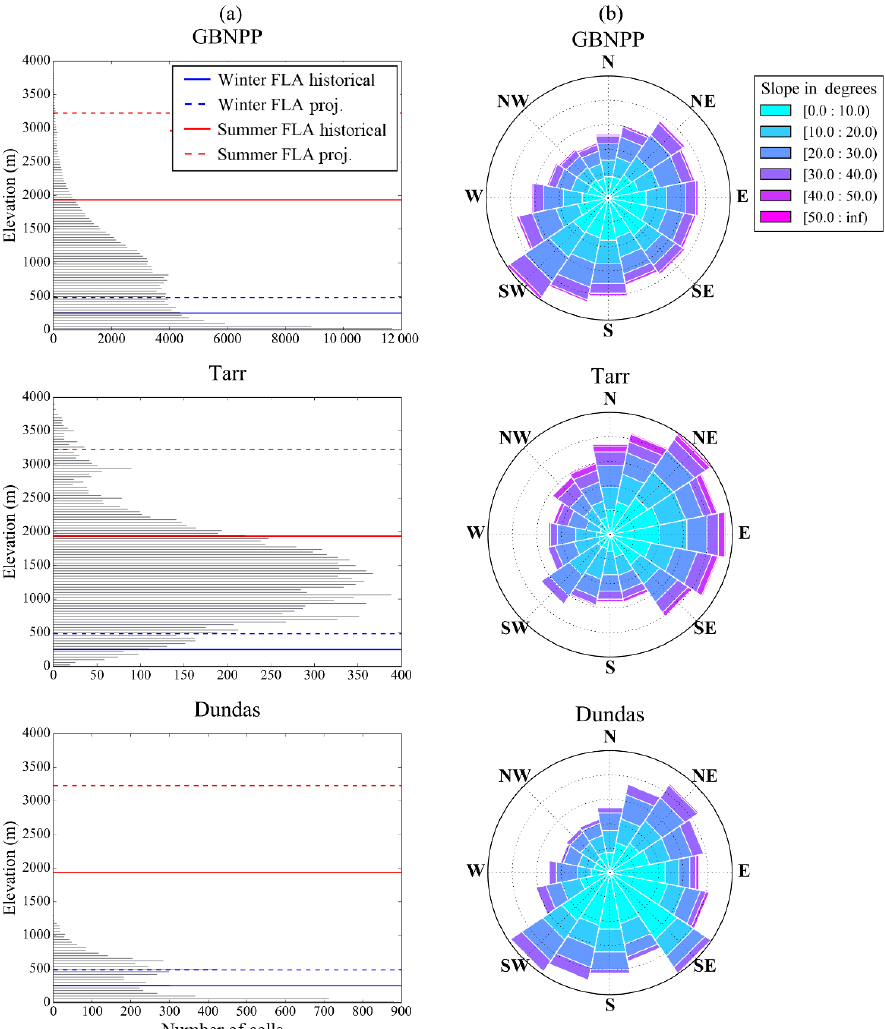
Figure 10. Landscape characteristics. (a) Elevation histograms for GBNPP, Tarr, and Dundas watersheds, with the average winter and summer freezing line altitudes (FLA) plotted in blue and red, respectively. Historical scenario (1979–2015) lines are solid, and projection scenario (RCP 8.5; 2070–2099) are dashed. (b) Polar coordinate plots for GBNPP, Tarr, and Dundas displaying the binned aspect and slope distributions within each